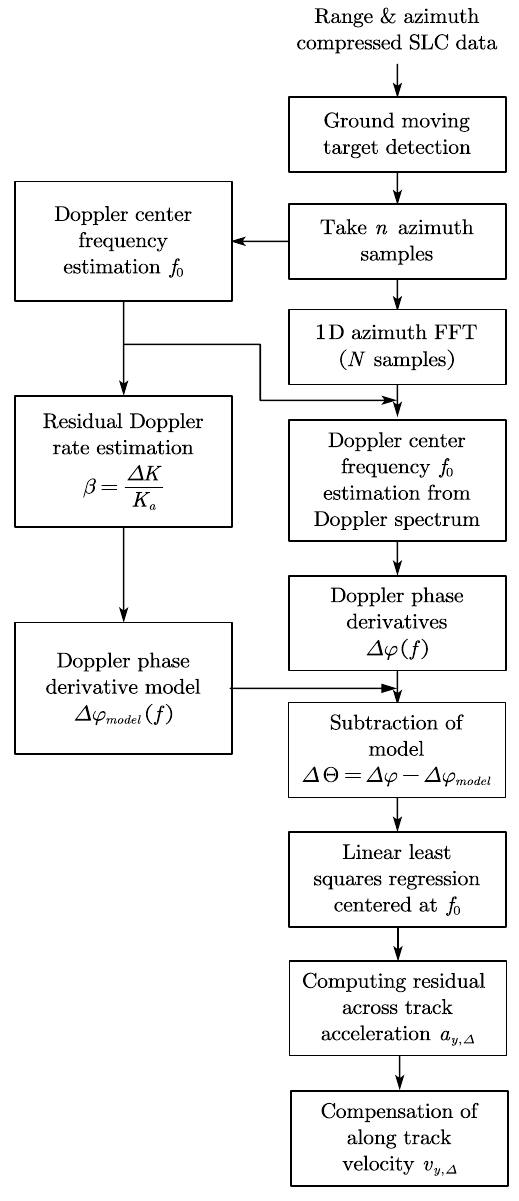
Figure 2. Processing flow for along-track velocity compensation of ground moving target from single-channel SAR single-look complex (SLC) data.